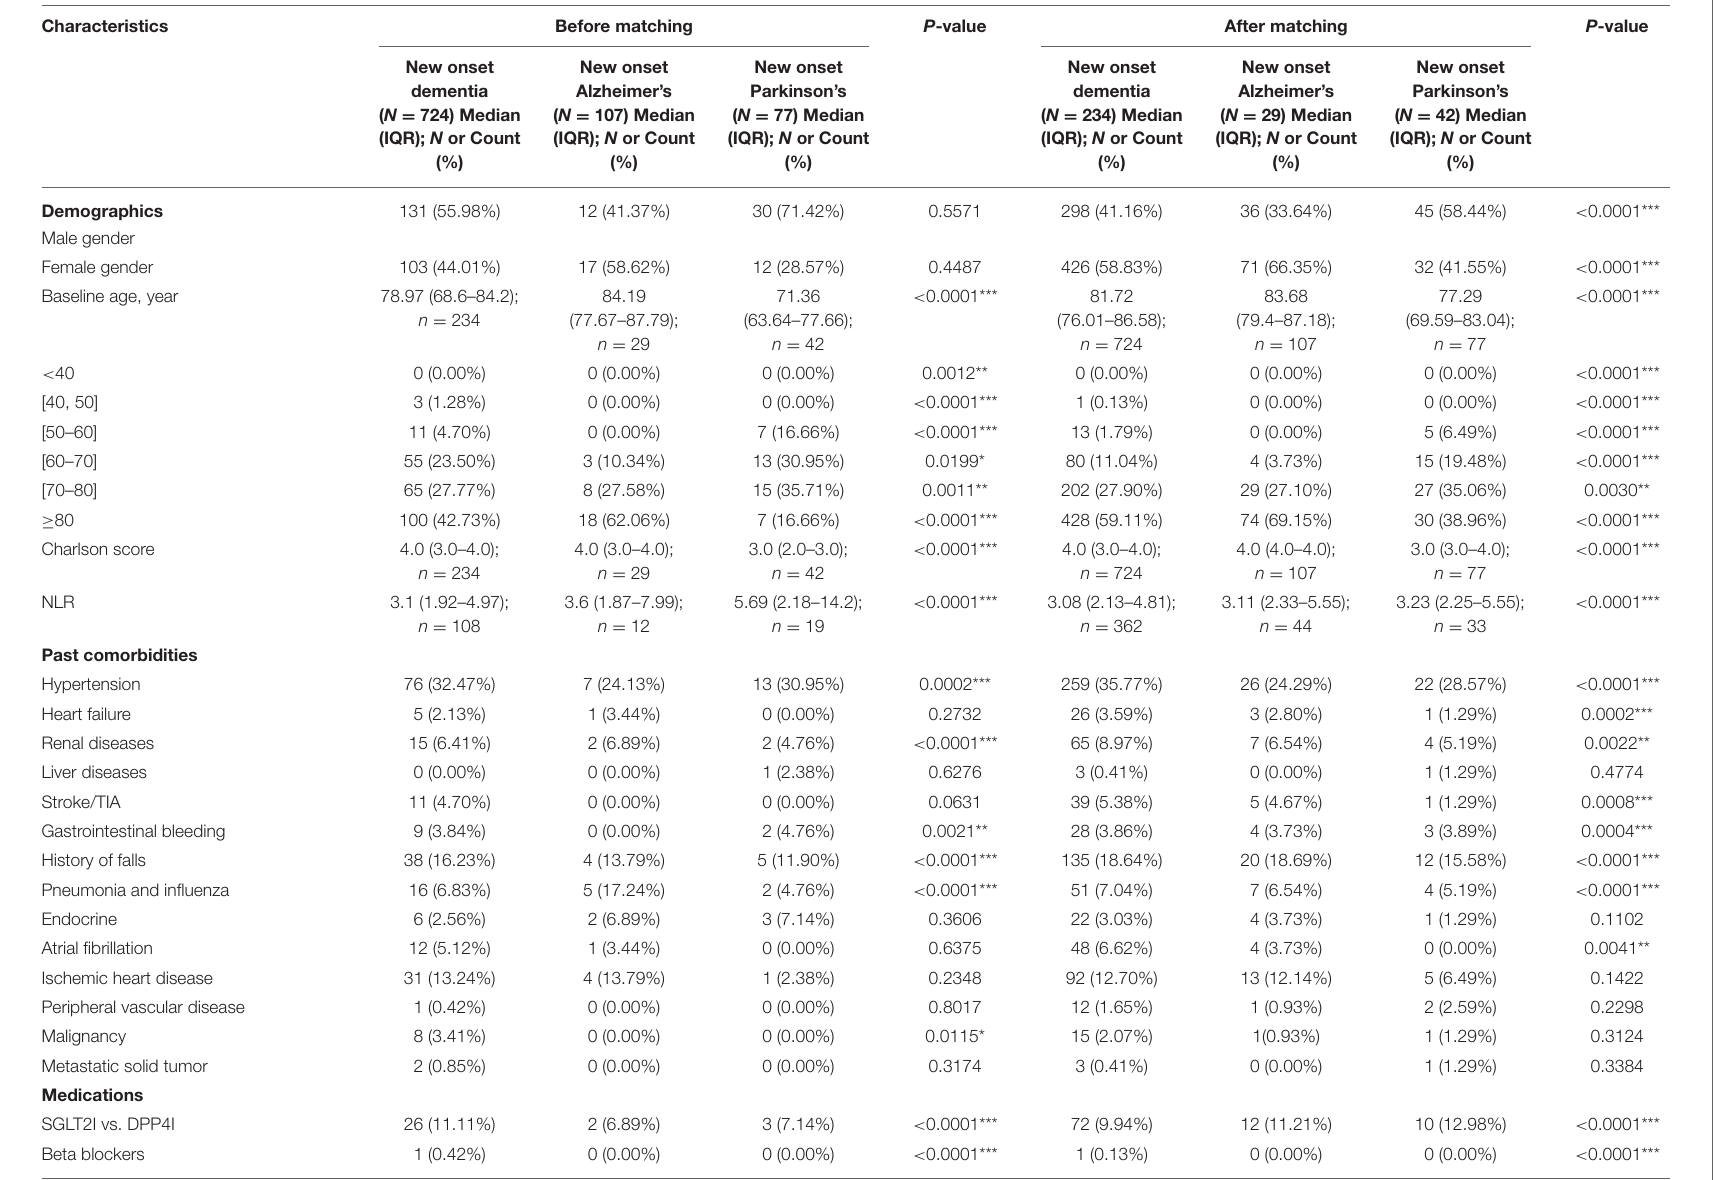
TABLE 2 | Baseline and clinical characteristics of patients with new–onset dementia, Alzheimer’s, and Parkinson’s before and after propensity score matching (1:2).